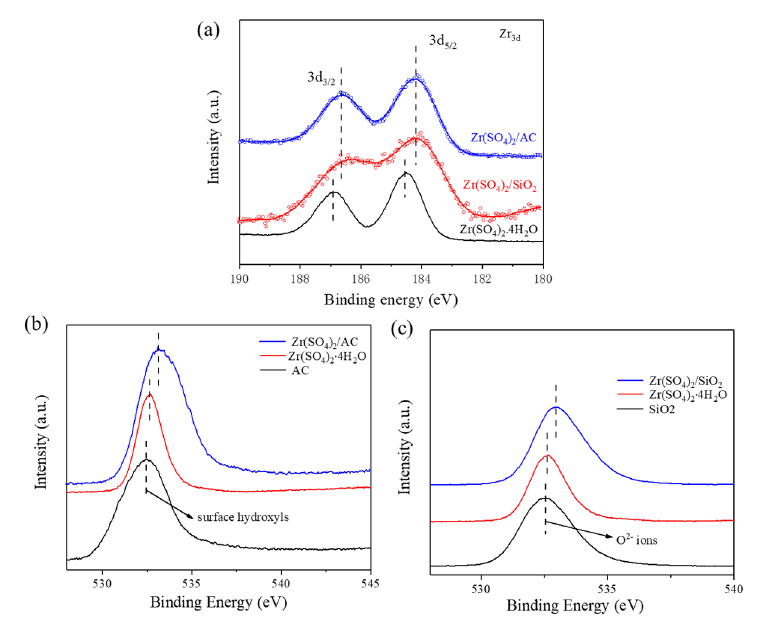
Figure 4. ( a ) XPS spectra at Zr3d binding energy region, and ( b , c ) XPS spectra at O1s binding energy region. Table 3. Binding energies of the Zr3d and O1s regions of various samples.